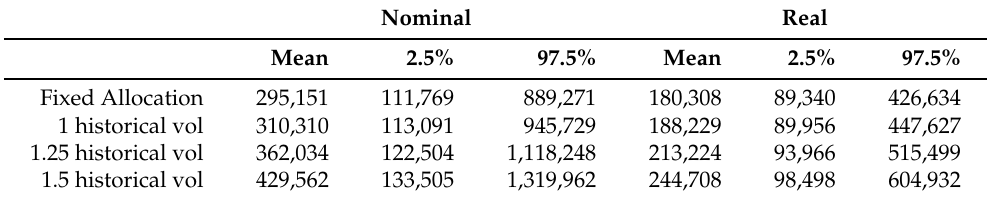
Table 13. PV Annuity Payments at Different Fixed Target Volatilities.